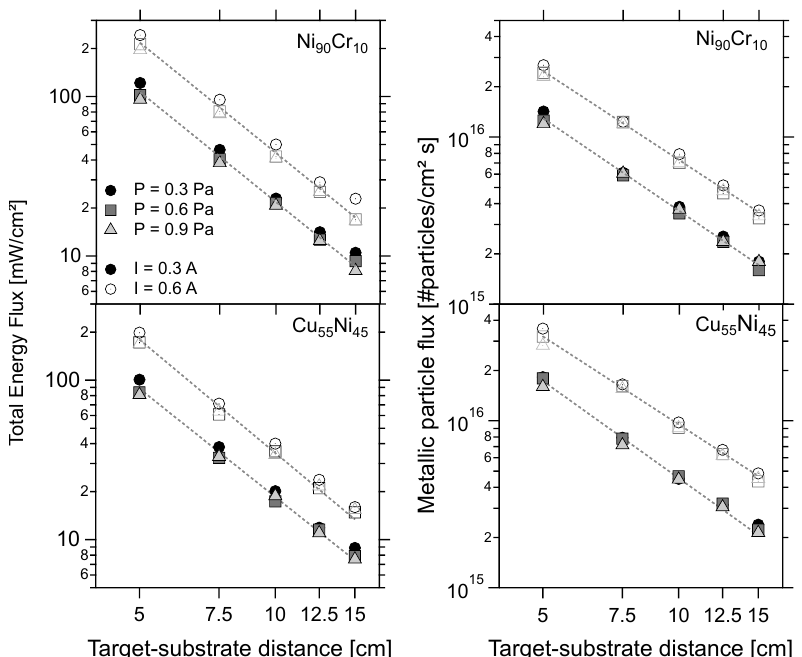
Figure 3. The total energy flux ( left ) and material flux ( right ) as function of the target-to-substrate distance for three argon pressures (0.3, 0.6, and 0.9 Pa) and two discharge currents (0.3 A (closed markers) and 0.6 A (open markers)). The two top panels present the data for chromel (Ni 90 Cr 10 ). The bottom panels shows the same data for constantan (Cu 55 Ni 45 ). The lines are a guide for the